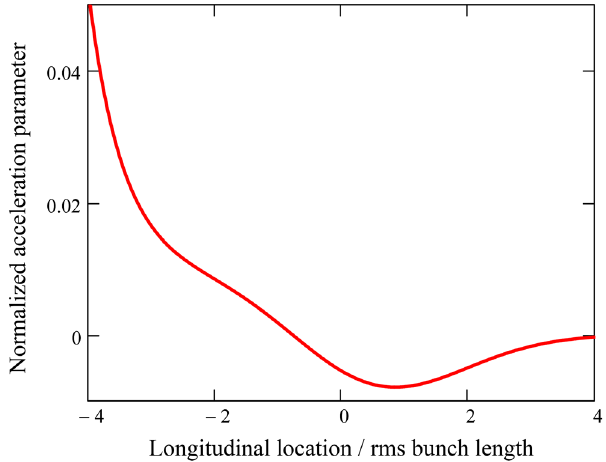
12. Normalized acceleration parameter due to resistive wall impedance as function of the longitudinal coordinate within a bunch. Parameters for eRHIC CeC scheme are